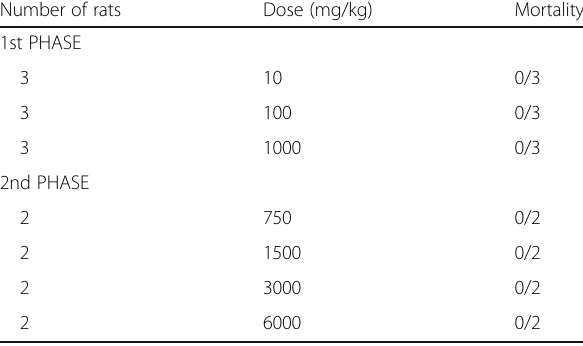
Table 5 Acute oral toxicity test (LD 50 ) of AGE Number of rats Dose